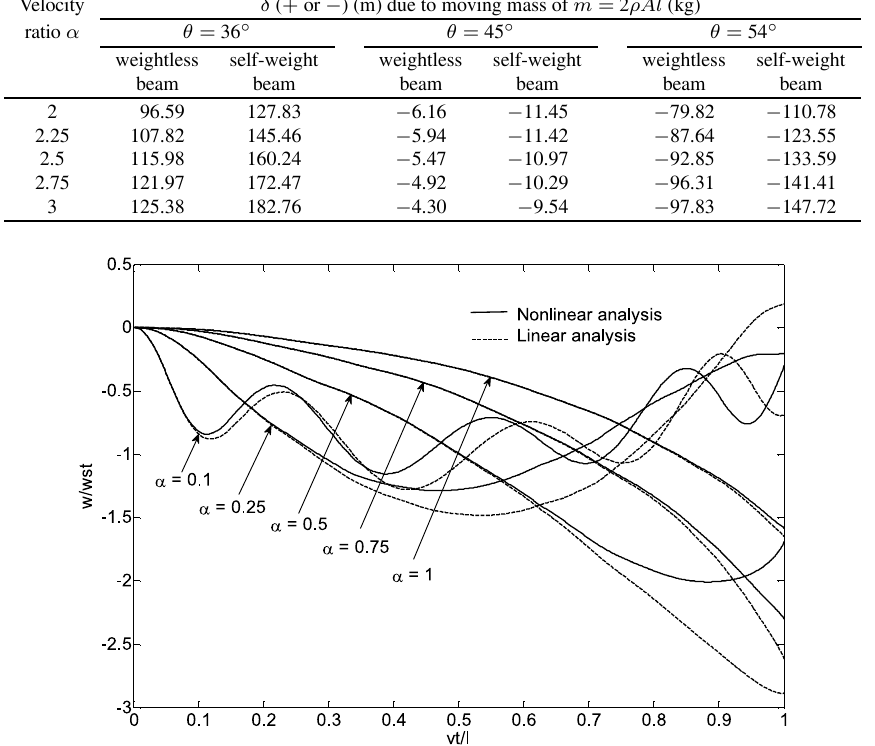
Fig. 8. Time histories for normalized mid-point de fl ection of an inclined self-weight Timoshenko beam, θ = 36 ◦ , m = 1.2 ρ Al (kg). (—–) nonlinear analysis, ( ) linear